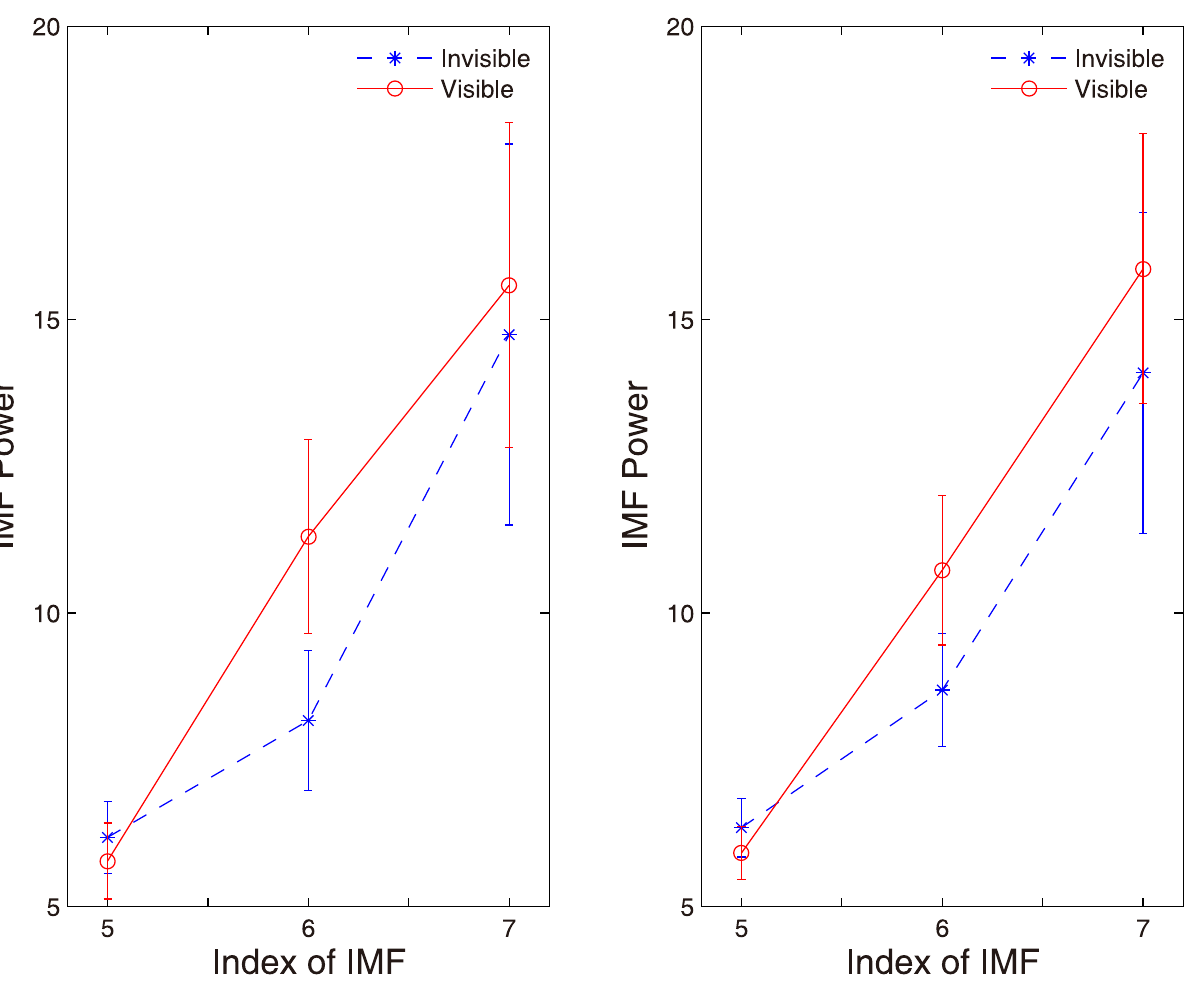
Figure 7. Discrimination of two perpetual conditions based on the identified information-bearing IMFs by (A) the proposed approach and (B) the method in [12]. It is clear that the IMF 6 in both methods show the most significant difference in power of two conditions, yet with a larger separation for the proposed method ( p , 0.01). The error bars denote the SEM.